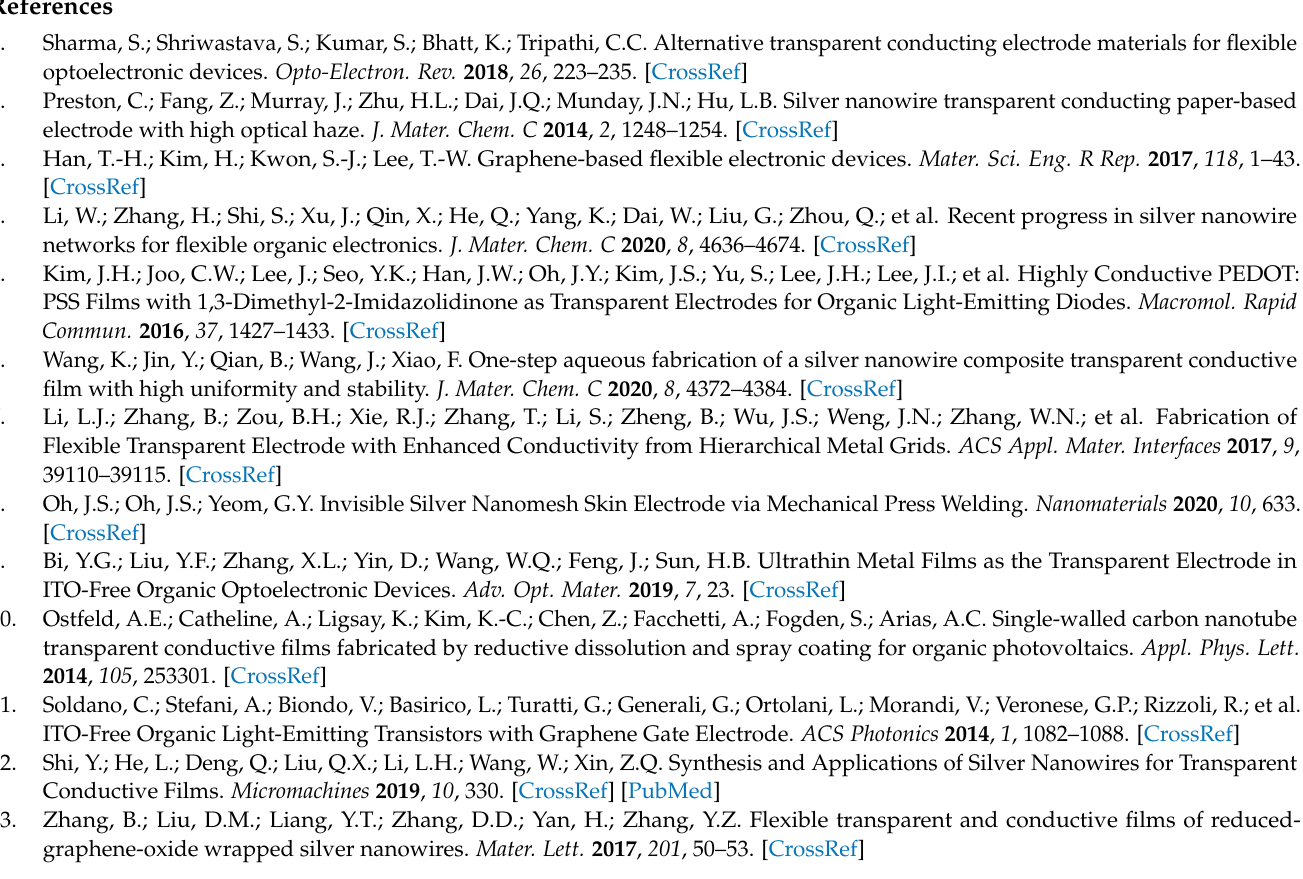
glass, Figure S4: Force–displacement curves for TCFs with and without MXene on glass substrates, Figure S5: Sheet resistance as a function of time at 180 ◦ C on a hotplate for 180